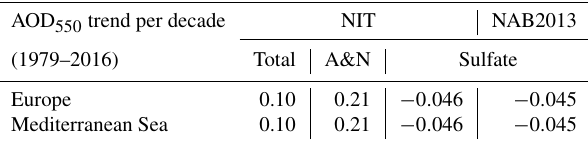
Table 7. NIT simulation AOD 550 trend per decade compared to NAB2013 (Nabat et al., 2013) over the period 1979–2016. AOD 550 trend per decade NIT NAB2013